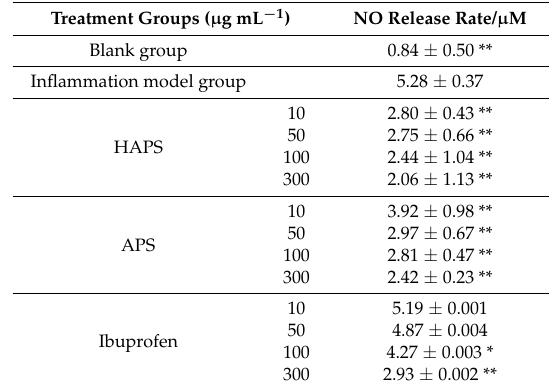
Table 4. Results of NO release after treatment of different concentration HAPS and APS.